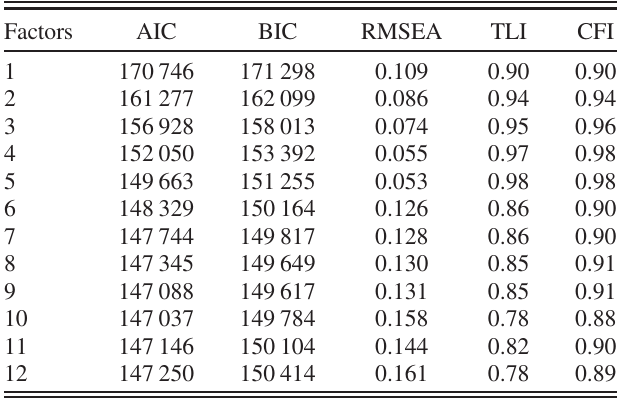
TABLE I. MIRT fit statistics for an exploratory factor analysis of the FMCE.